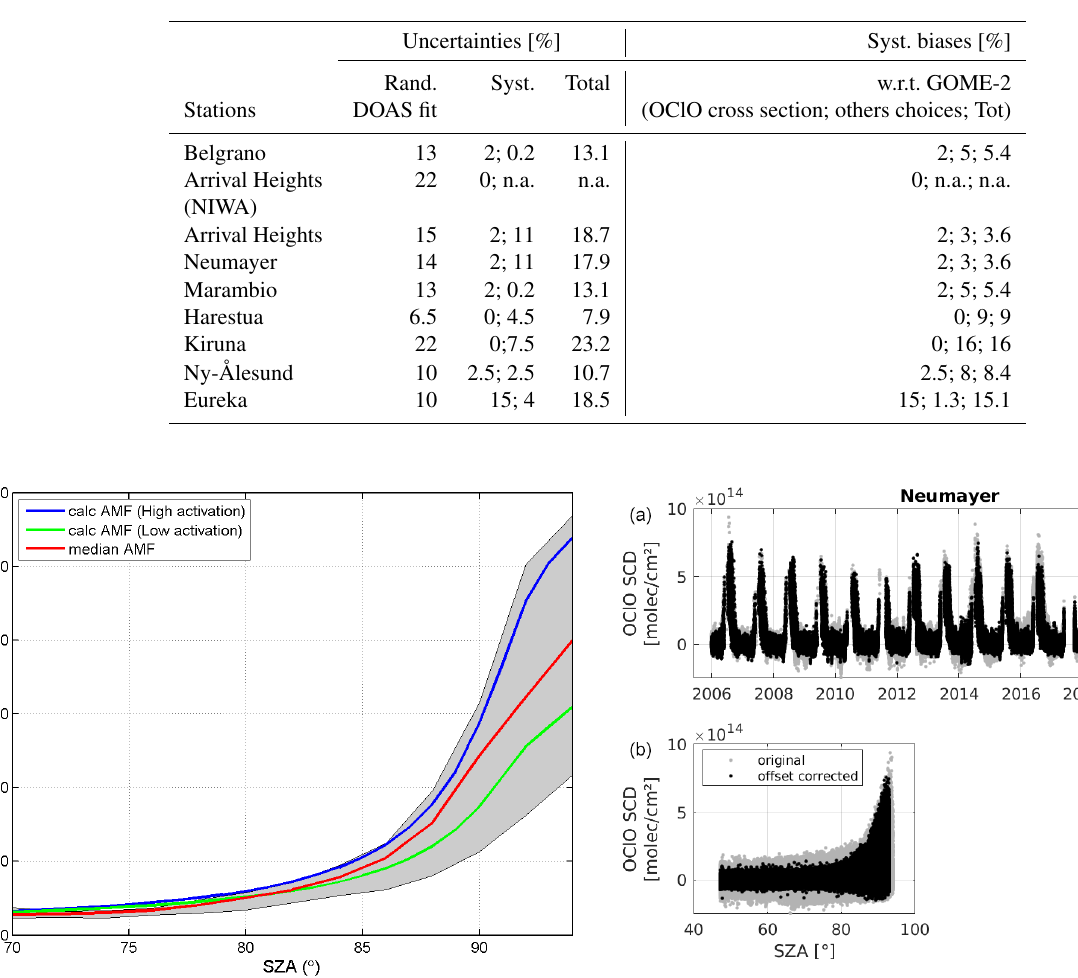
Table 3. Error estimates for the different OClO analysis at each station (in percent). The random uncertainty is estimated from the DOAS fit uncertainty for an OClO SCD of 15 ± 2 × 10 13 molec.cm − 2 . The systematic uncertainty is evaluated considering the impact of using different OClO cross sections and different retrieval settings (see Sect. 3.1.1., Figs. A1 and A2, and Table A2). The total uncertainty is calculated as the quadrature sum of random and systematic contributions. Estimation of the expected systematic bias with respect to the GOME-2 analysis setting is given in the right-hand column (see Sect. 3.1.1. and Fig. A3).